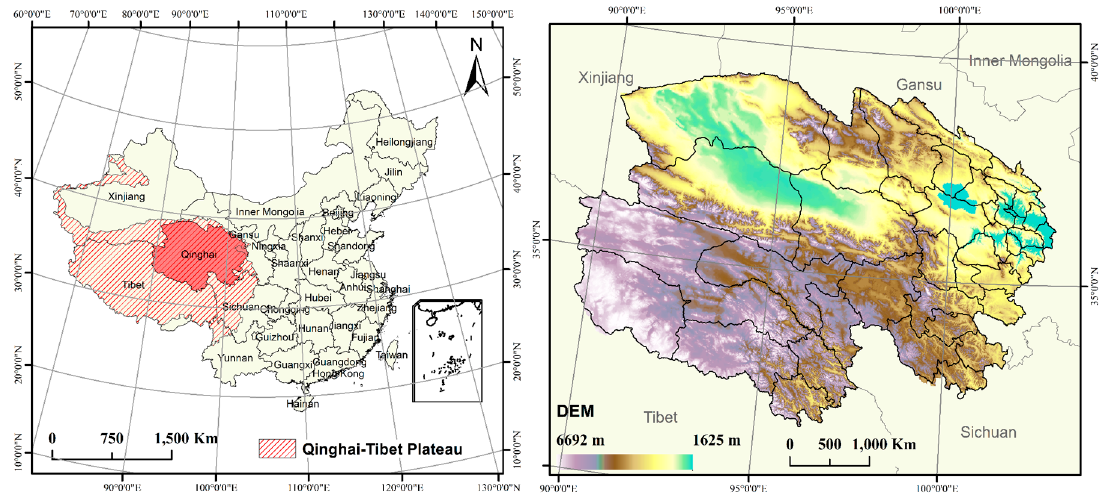
Figure 1. Geographic position of Qinghai Province.